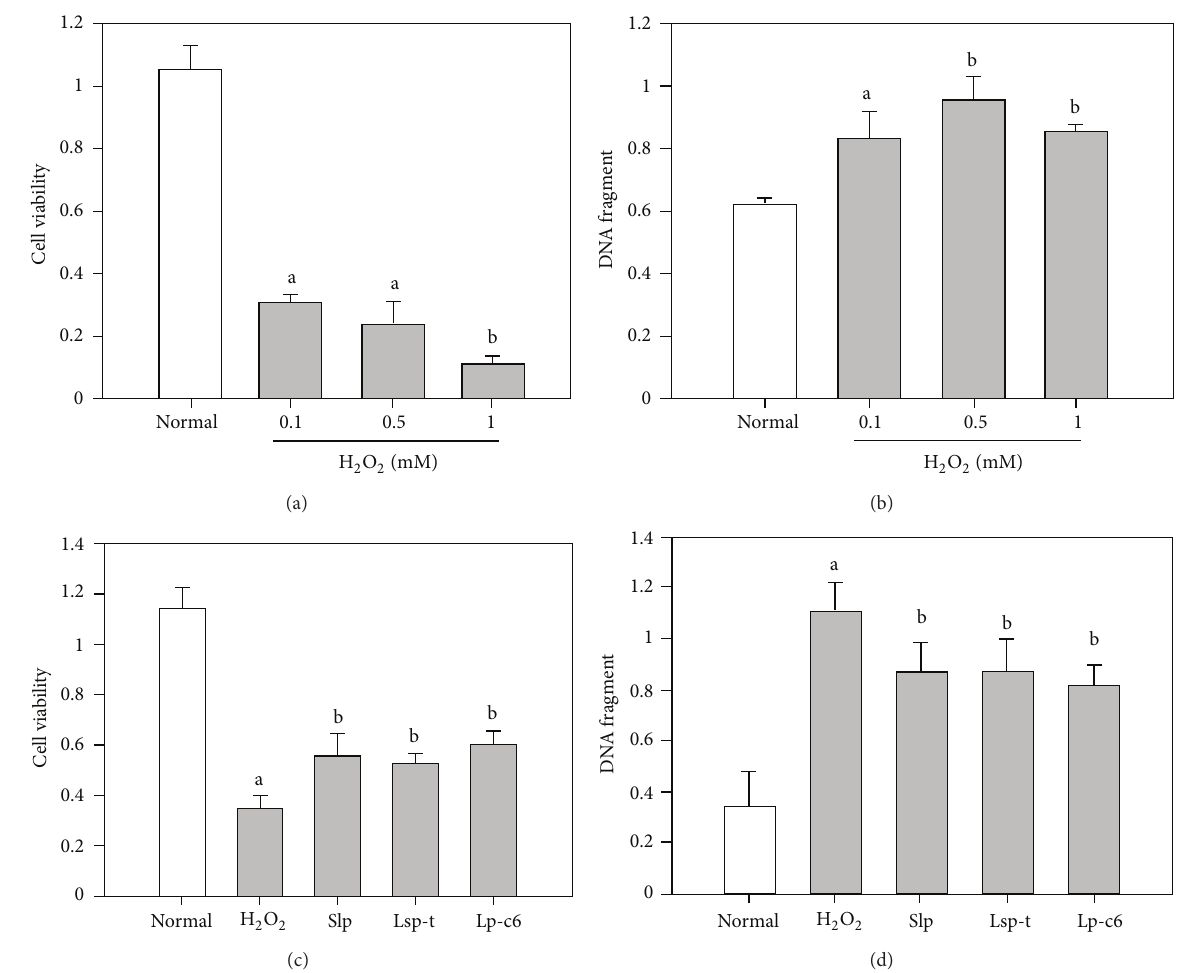
Figure 5: Effects of Slp and Lsp-t on H 2 O 2 -treated BmN cells. (a) Analysis of BmN cellular viability on exposure to different concentration of H 2 O 2 as determined by MTT assay. (b) DNA fragmentation analysis on exposure of BmN cells to different concentration of H 2 O 2 as determined by ELISA. (c) Effects of Slp and Lsp-t on cell viability on exposure to different concentrations of H 2 O 2 as determined by MTT assay. (d) Effects of Slp and Lsp-t on DNA fragmentation in H 2 O 2 -treated BmN cells by ELISA. Purified silkworm lipoprotein 30Kc6 (Lp- c6) was used as a positive control. Different letters refer to the levels of statistical significance where there was a significant difference at the 𝑃 < 0.05 level. Where the letters match, this refers to no statistical difference between the sets of